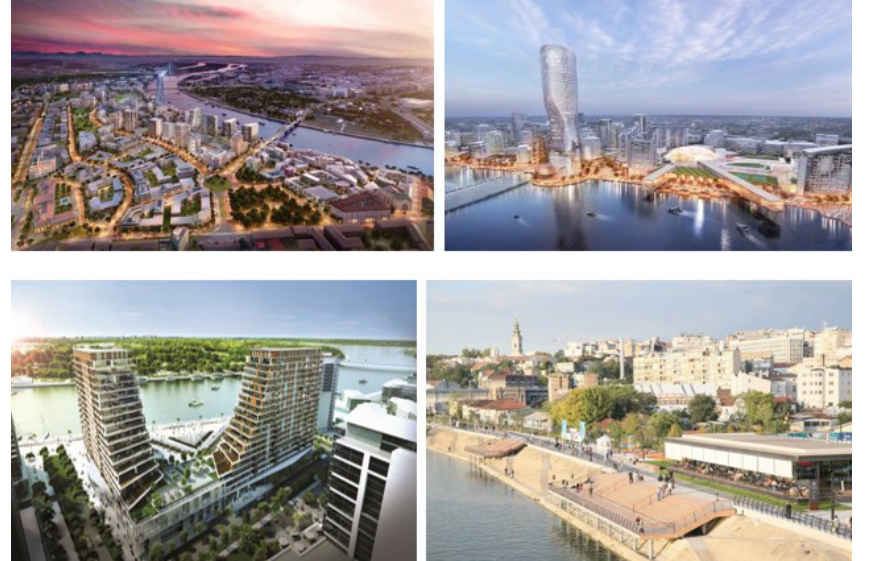
Figure 10. Transformation of the Sava waterfront "Belgrade on the Water"(https://www.belgradewaterfront.com/en/)